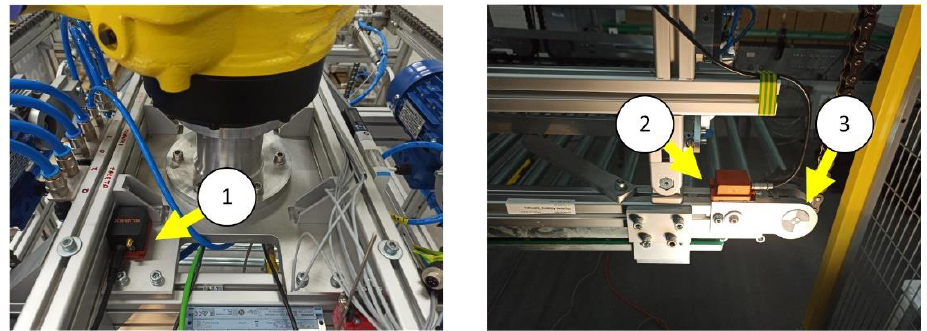
Figure 9. MTi XSENS sensor mounting location. 1—sensor on the robot flange, 2—sensor on the gripper, 3—tag for the camera.